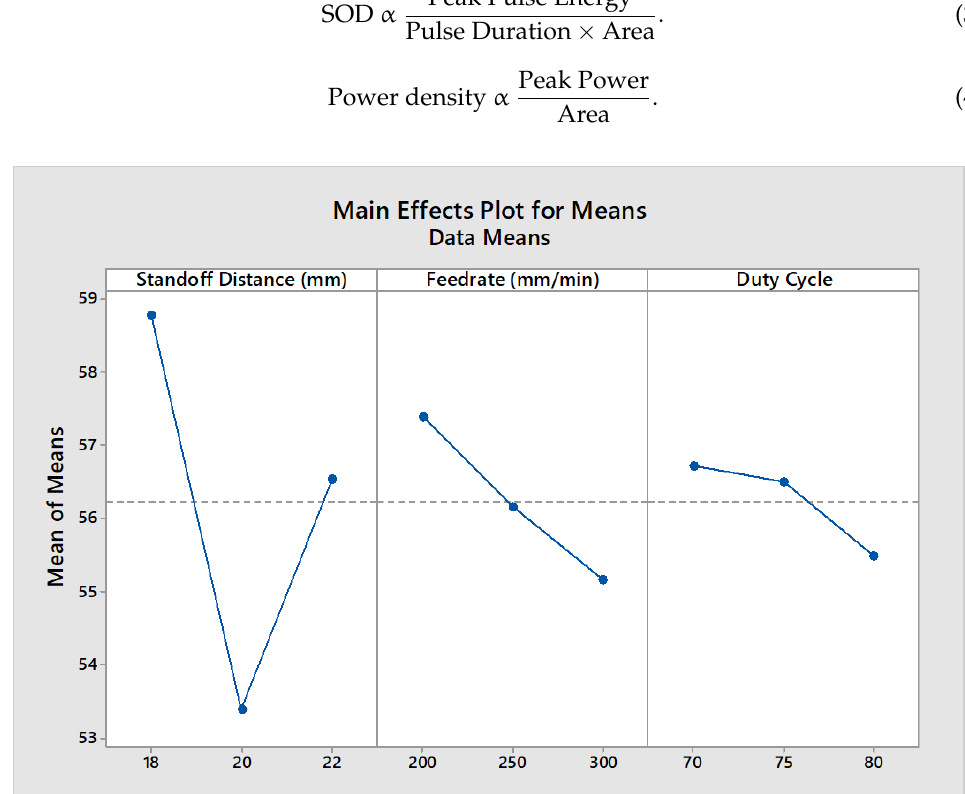
Figure 5. MEP of process factors on carbonization.